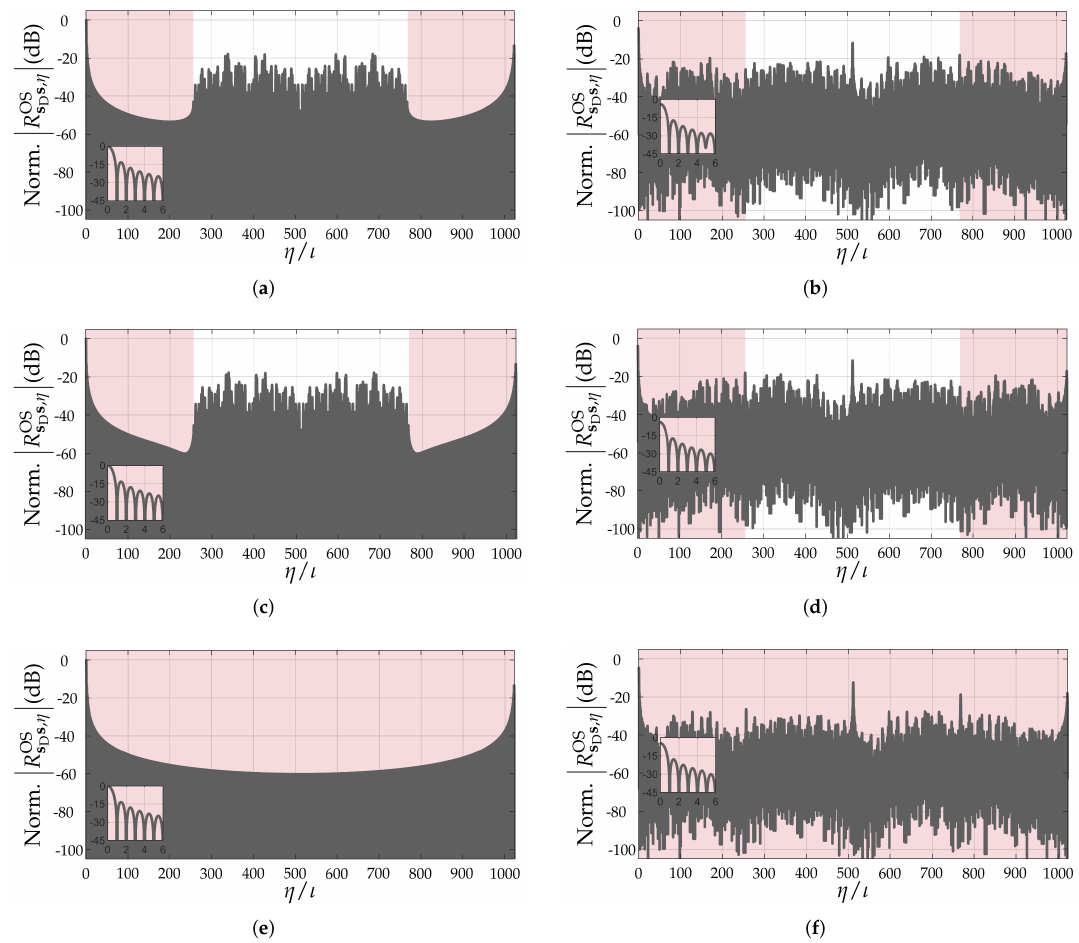
Figure 7. Normalized oversampled PACFs ( ι = 20) under f D / ∆ f = 0 and | f D / ∆ f | = 0.5 of Golay sequences ( a , b ) A and ( c , d ) B acting as ZCZ sequences, and ( e , f ) sum of the PACFs of the comple- mentary Golay sequences A and B. An with approximate length of N PRBS = 1024 was adopted for all PRBSs. The relevant PACF intervals described in Section 3 are highlighted in